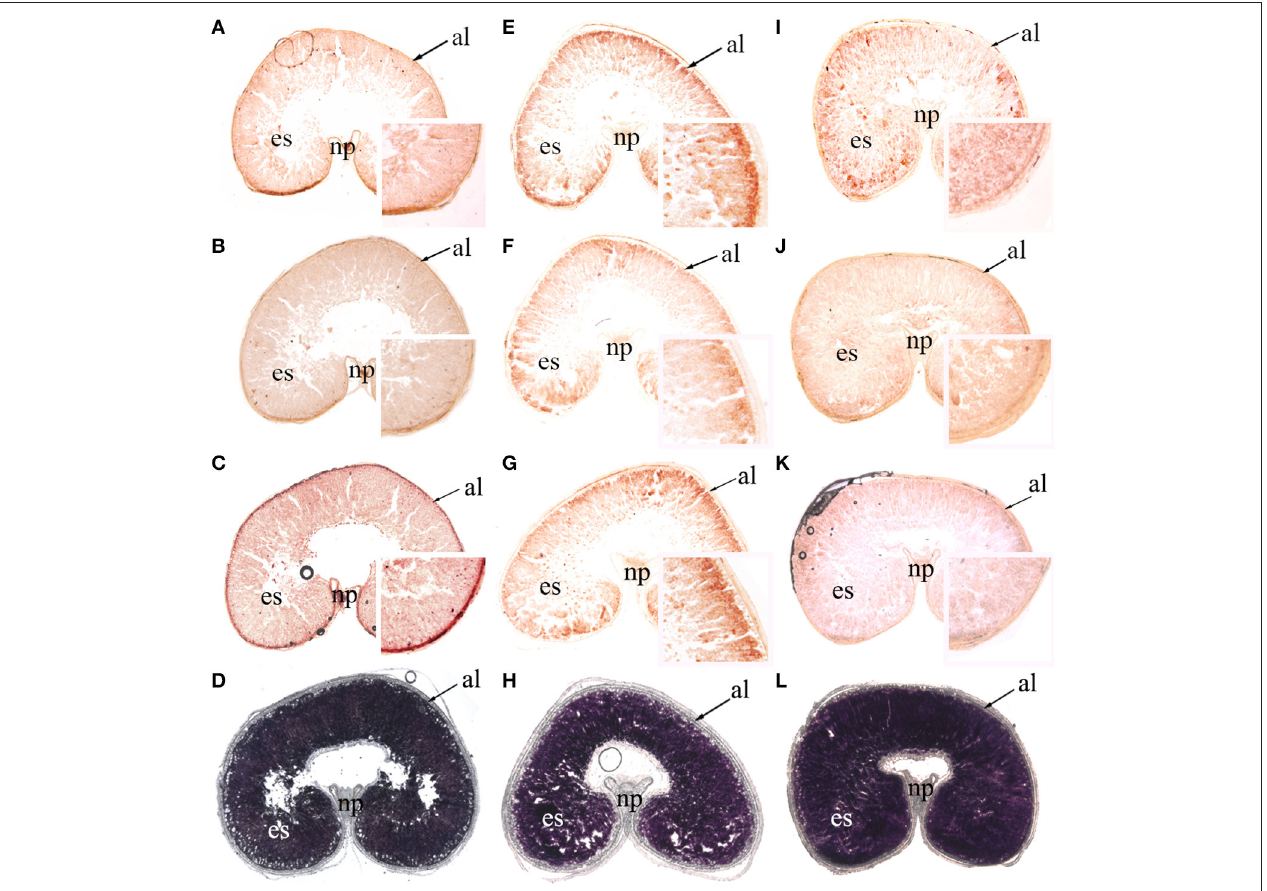
FIGURE 7 | In situ localization of AMY4 , BAM1, and BAM5 t ranscripts and starch accumulation in wheat caryopses at 28 days post anthesis ( × 25, magnified insets × 150). Hybridization sites of AMY4 (A,E,I) , BAM1 (B,F,J) , and BAM5 (C,G,K) transcripts were visualized as reddish-brown signals in median transverse sections of wheat grains in the 0kg P ha − 1 (P0) treatment (A–C) , 46kg P ha − 1 (NP) treatment (E–G) , and 92kg P ha − 1 (HP) treatment (I–K) . Starch granules were stained with I 2 -KI in median transverse sections of wheat grains in P0 (D) , NP (H) , and HP (L) . al, aleurone; es, endosperm; np, nucellar projection. The thickness of these sections was 20 µ